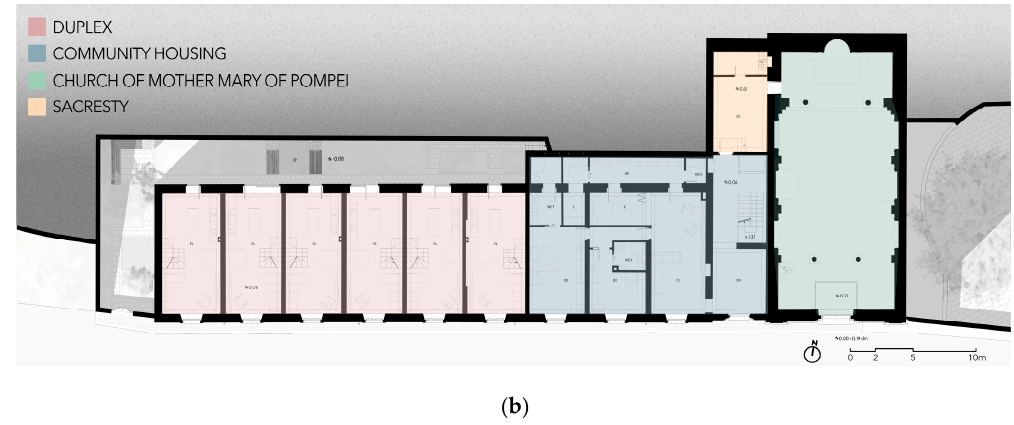
Figure 7. The adaptive reuse project. ( a ) First floor plan. ( b ) Ground floor plan.